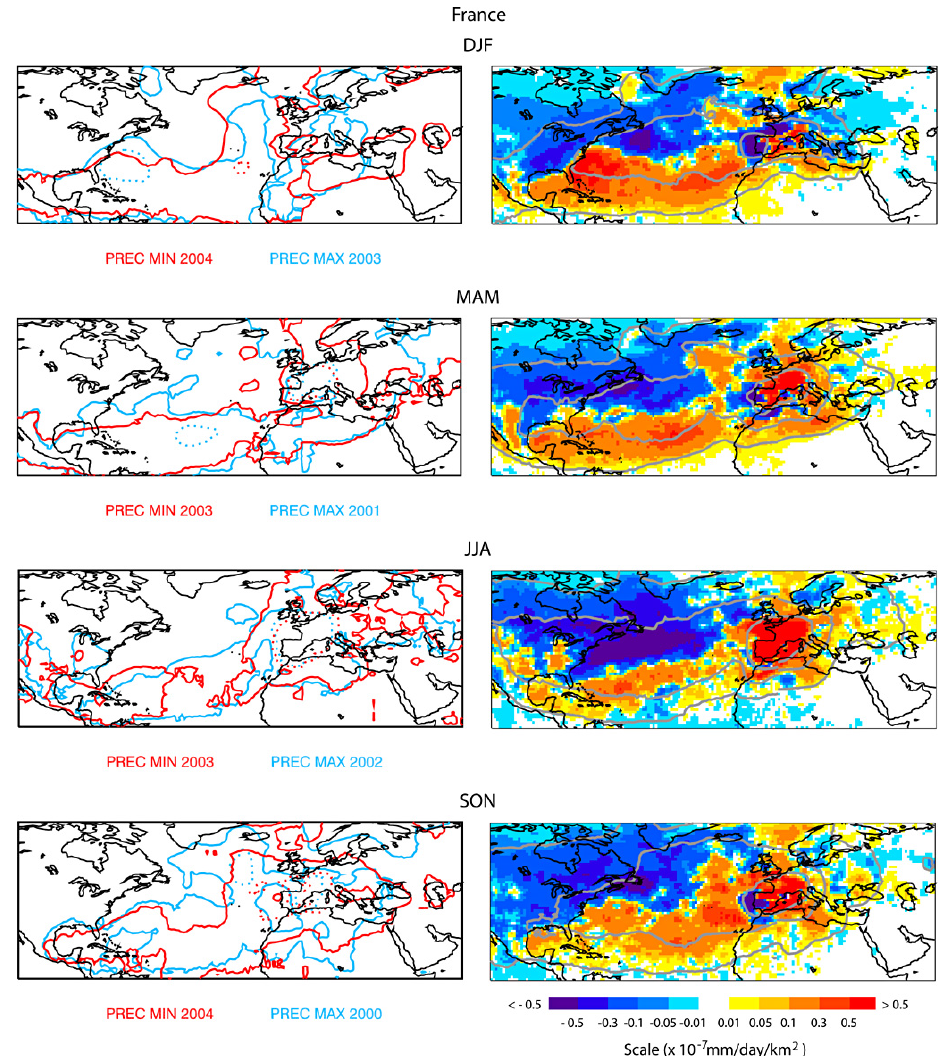
Fig. 3. As Fig. 2, but for France (F), considering its equivalent area as 277264km 2 .